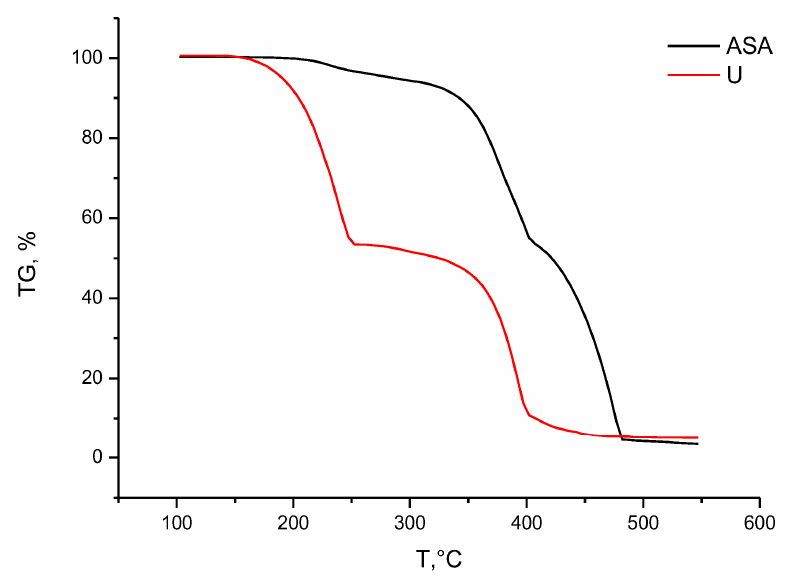
Figure 3. Thermogravimetric analysis of ammonius sulfamate (ASA) and Urea (U) .